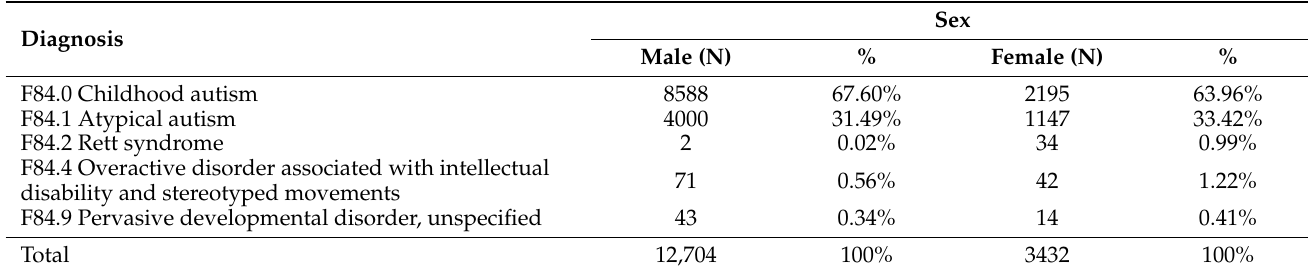
Table 4. Distribution of diagnoses per sex.